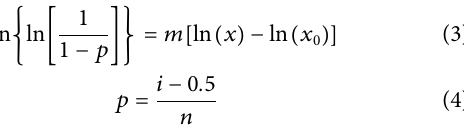
Frontiers in Materials |